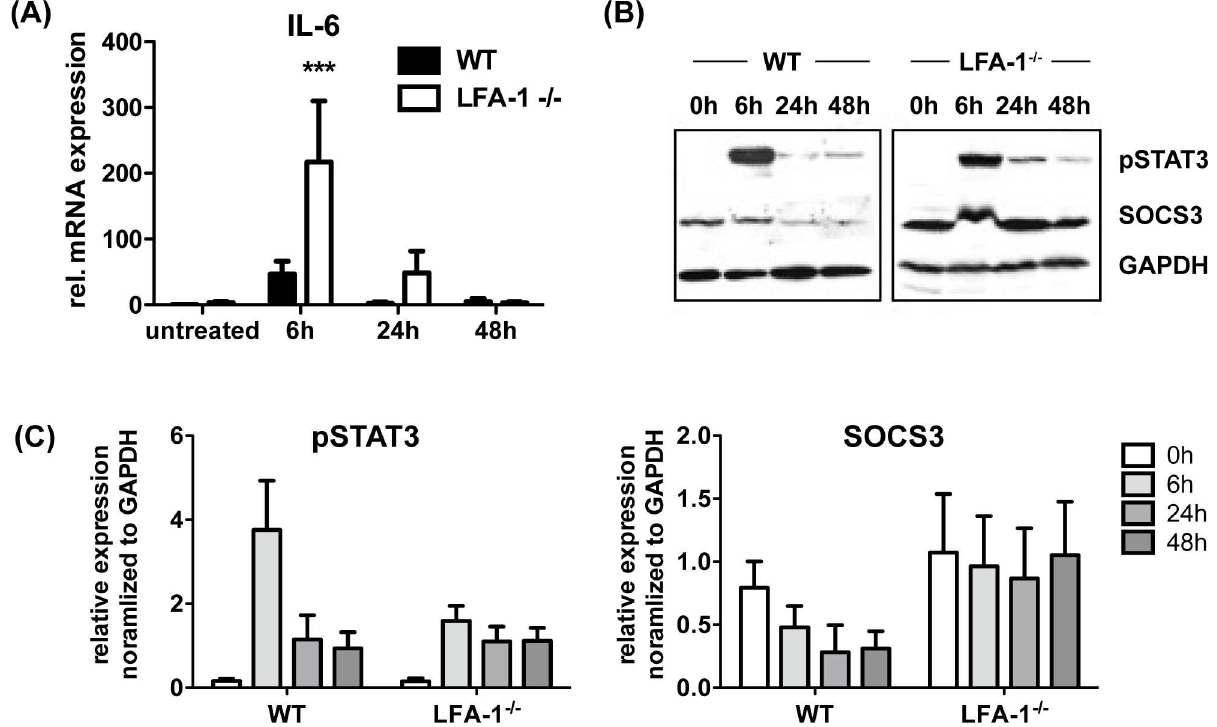
Fig 6. Increased level of IL-6 mRNA in the regenerating liver of LFA-1 -/- mice is accompanied by low level of phosphorylated STAT3 (pSTAT3) but increased amount of SOCS3 protein. PH in presenceof 50 μ gLPS per 20g body weight was performed in WT and LFA-1 -/- mice and amount of (A) IL-6 specific mRNA within the liver parenchyma was analyzedby qRT-PCR. IL-6 specific mRNA in the liver of untreatedWT mice was definedas standardvalue 1 (mean ± SD from 3 mice). (B) Detection of pSTAT3 and SOCS3 protein in the regenerating liver of WT and LFA-1 -/- mice upondepicted timepointafter surgery. GAPDH served as loadingcontrol (representative immunoblot). (C) Quantification of results in (B) are depictedas mean ± SD from 3 mice for each